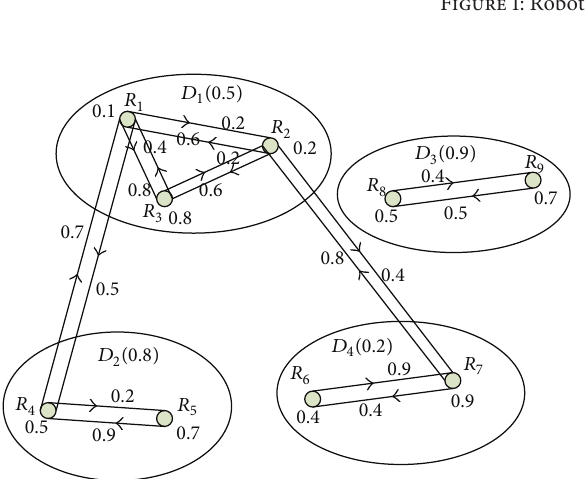
Figure 1: Robot collaboration system.